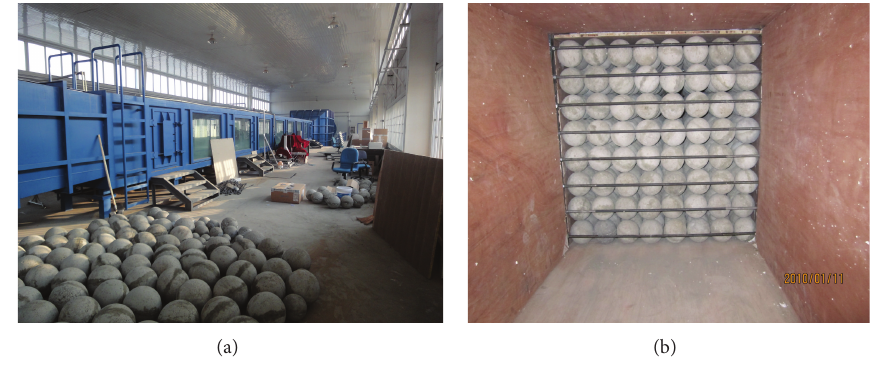
Figure 1: The wind tunnel facility and laying mode of